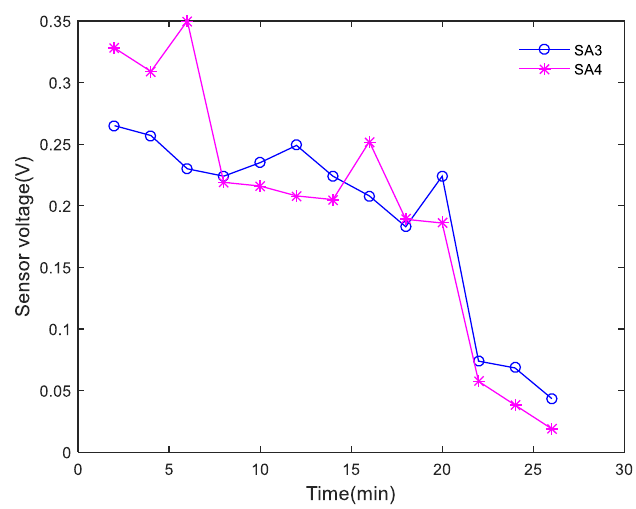
Figure 13. Peak curve of the amplitude of each received SA signal for Composite specimen I.